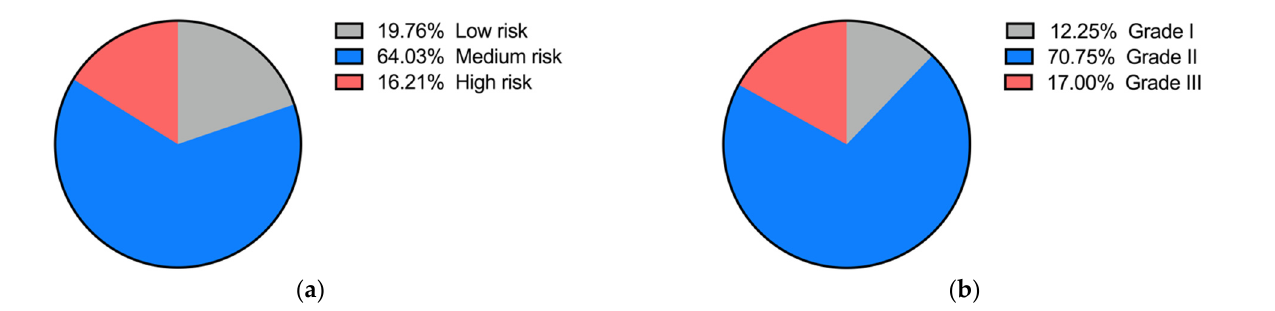
Figure 9. ( a ) Proportion of each caries risk grade; ( b ) Proportion of each treatment difficulty grade.